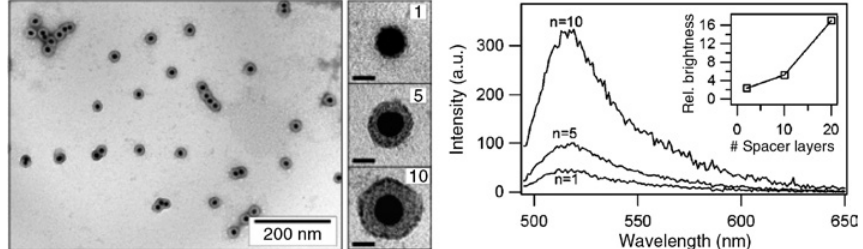
Figure 16: Left: TEM overview on particles bearing 10 primer pairs of PAH/PSS layers and further coated with PAH-FITC, Au(PAH/PSS)10(PAH- FITC). Right column: TEM of layer-by-layer-coated individual gold nanoparticles ensheathed with n = 1, 5, and 10 pairs of PAH/PSS spacer layers, respectively, with a last layer of PAH-FITC, Au(PAH/PSS)n-(PAH-FITC), before deposition of the terminating PSS layer. Right: Fully corrected emission spectra of core-shell nanoparticles of structure Au(PAH/PSS)n(PAH-FITC/PSS) (exc = 490 nm) in aqueous suspension. Adapted with permission from Ref. [86]. Copyright (2015) American Chemical